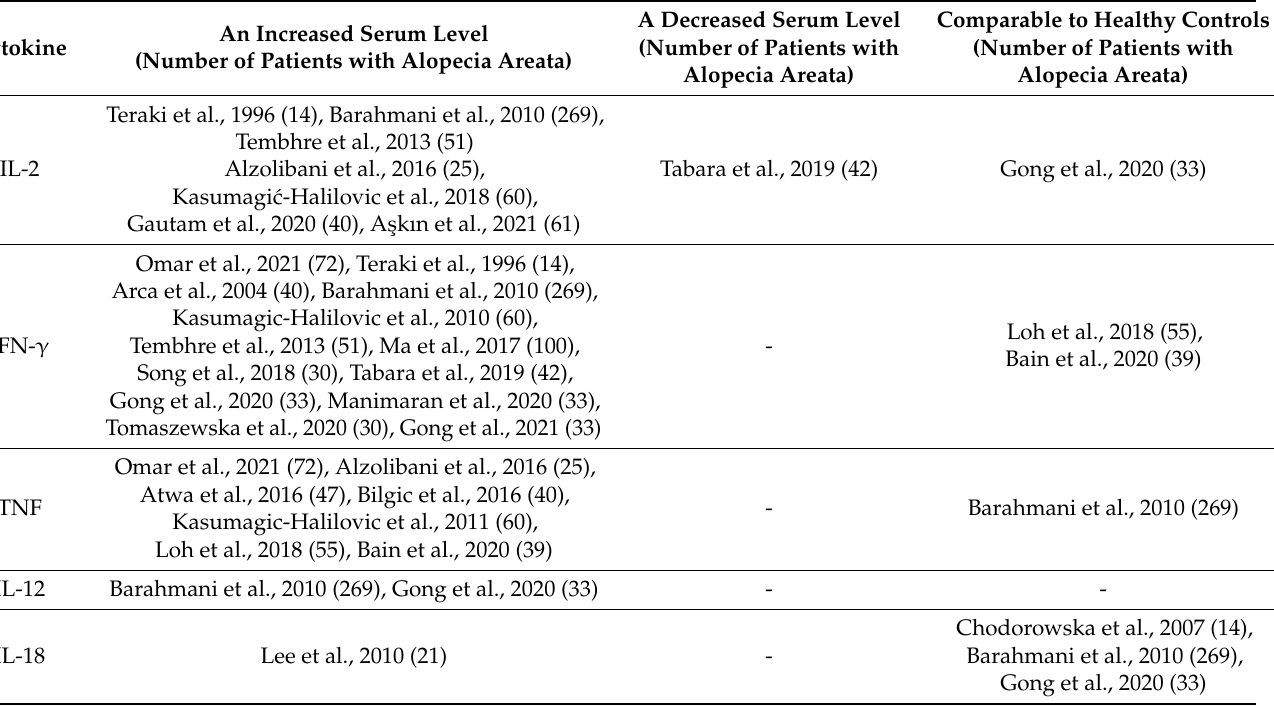
Table 1. Summary of current literature considering the serum Th1 cytokine levels in patients with alopecia areata. An Increased Serum Level Cytokine (Number of Patients with Alopecia Areata)